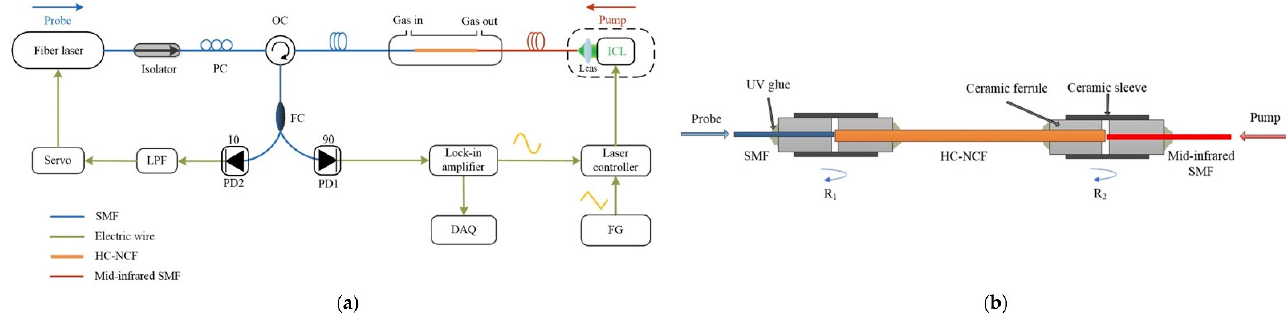
Figure 9. FPI PTS C 2 H 6 gas sensor based on the use of a mid-IR ARHCF. ( a ) Experimental setup. PC—polarization controller, OC—circulator, ICL—interband cascade laser, FG—function generator, DAQ—data acquisition card, PD—photodetector, LPF—low-pass filter, SMF—single-mode fiber, HC-NCF—hollow core negative curvature fiber. ( b ) The absorption cell is formed by the gas-filled HC-NCF (ARHCF), which is butt-coupled with a conventional SMF and mid-IR SMF. R 1 and R 2 indicate the reflections in the FPI cavity formed by the interfaces between the coupling points of these fibers. Reprinted with permission from [26] © The Optical Society.